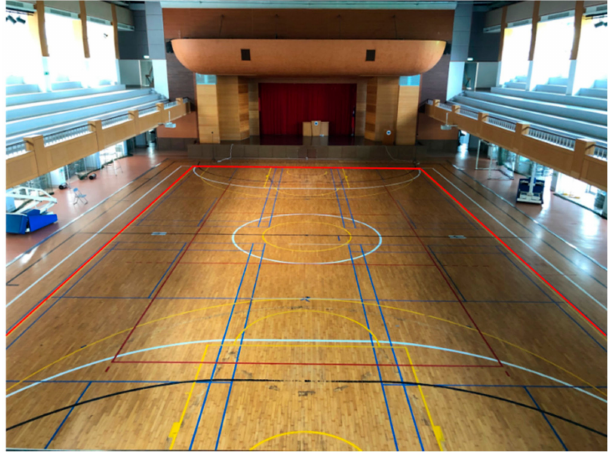
Figure 6. Experimental Environment–Basketball